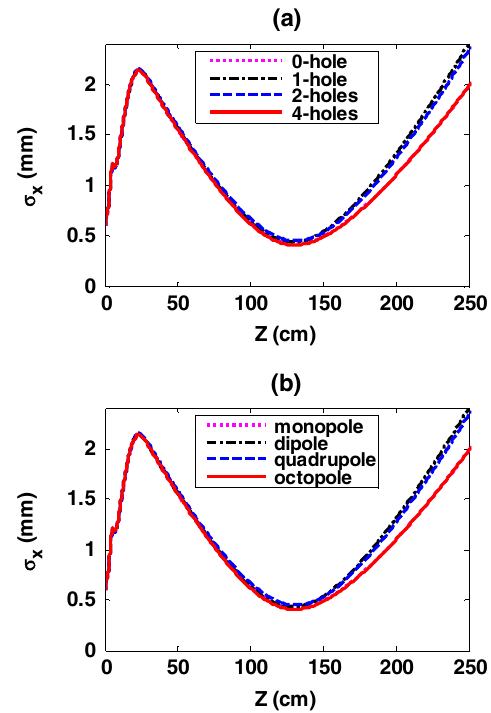
FIG. 10. X rms beam size of the rf gun with solenoid field for the beam charge 1 nC (a) with the four rf gun models and (b) with four artificial field maps.